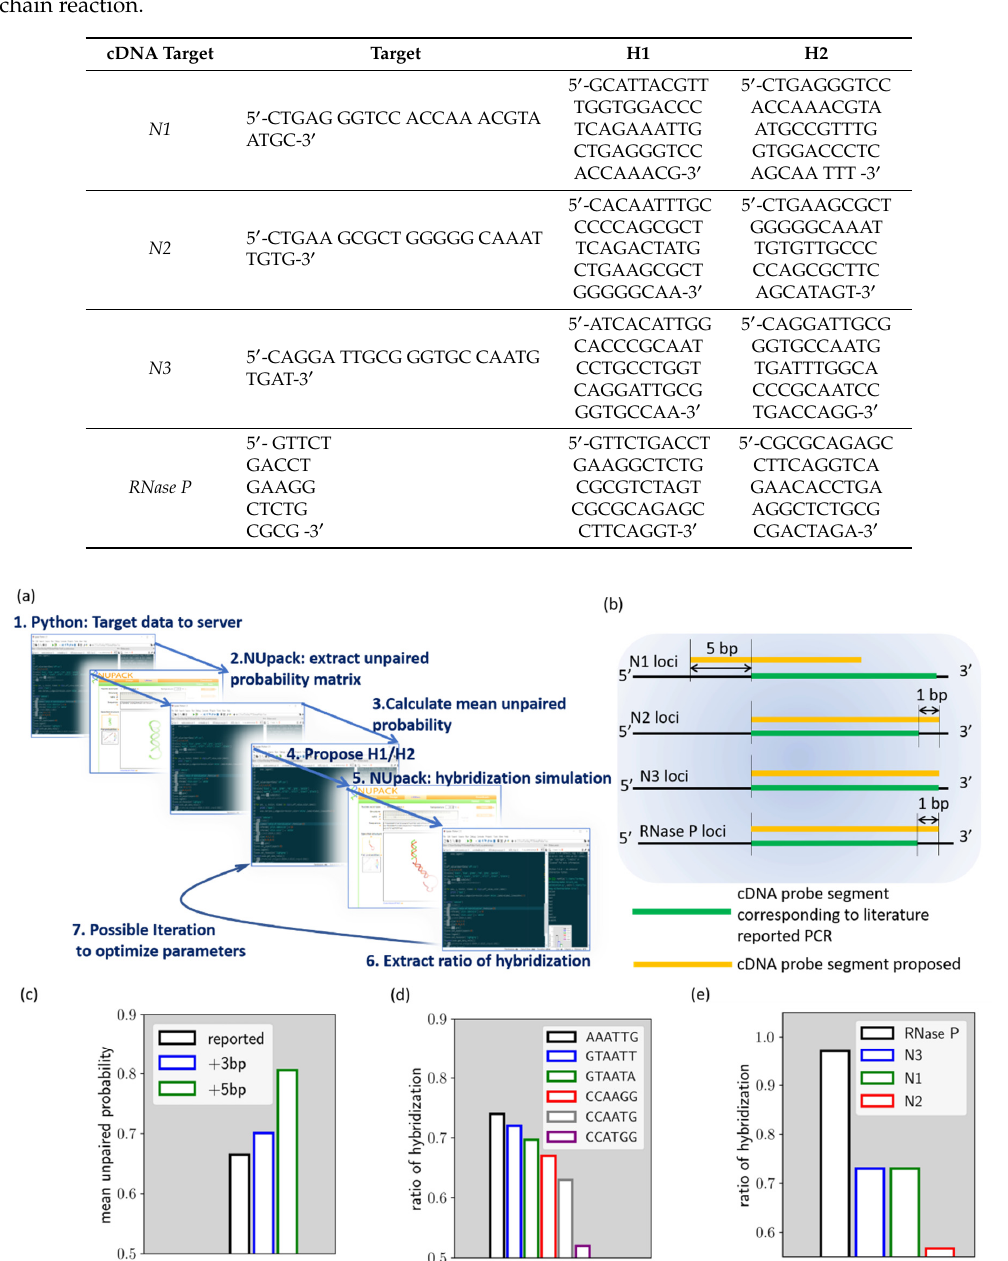
Table 1. Fuel hairpin molecule H1 / H2 and target sequence chosen for the SARS–CoV-2 hybridization chain reaction.